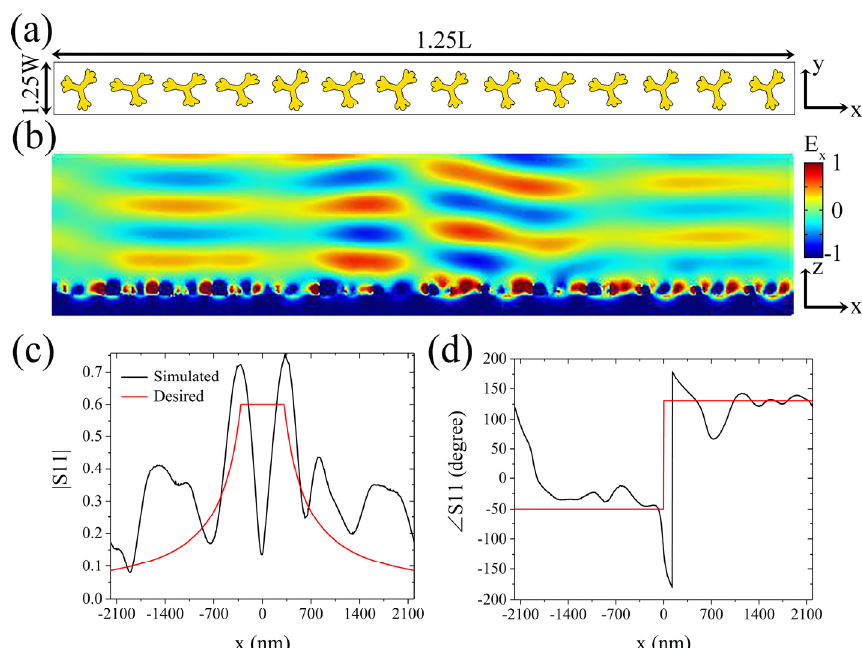
Figure 3. Simulation of the integral metasurface in the red band. ( a ) Metasurface model with a transverse magnification of 1.25 times. ( b ) Reflected co-polarized electric field profile obtained when red light of wavelength 632 nm is incident on the metasurface. ( c ) and ( d ) show the simulated (black line) and theoretical (red line) position-dependent reflection coefficient amplitude and phase, respectively.